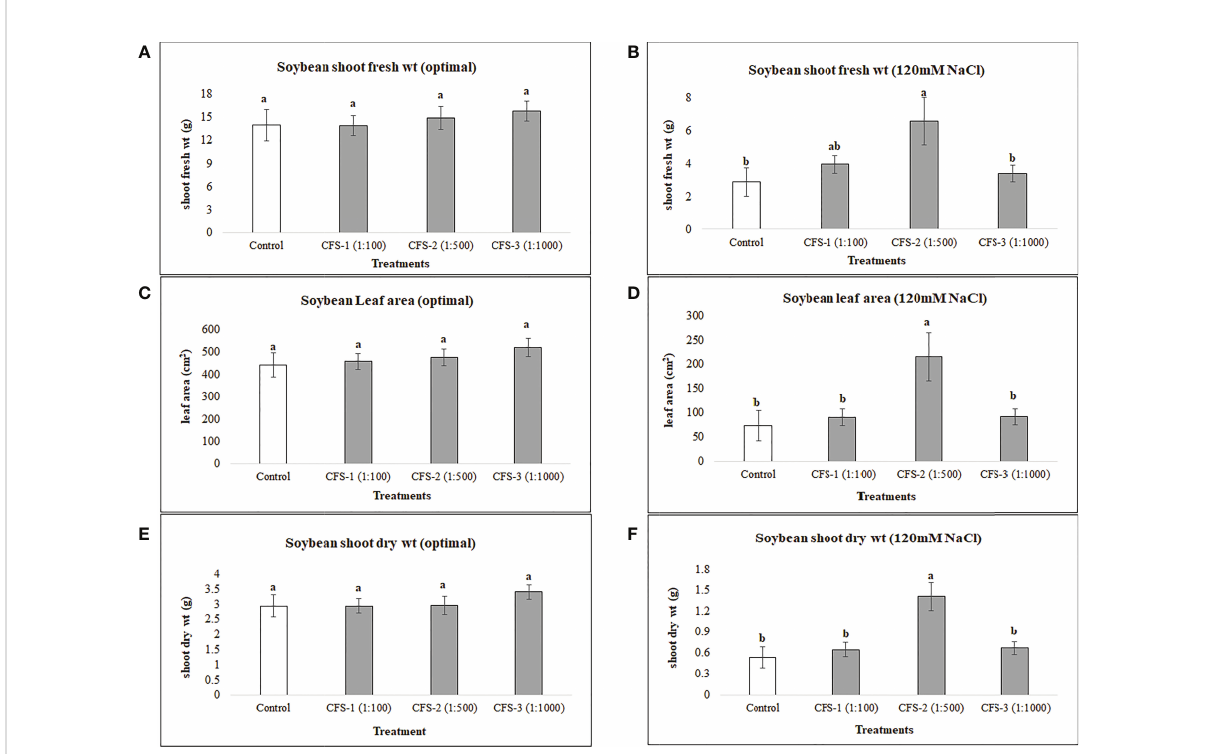
FIGURE 2 Soybean above ground biomass affected by CFS (A) shoot fresh wt - optimal (B) shoot fresh wt – 120 mM NaCl (C) shoot dry wt - optimal (D) shoot dry wt – 120 mM NaCl (E) leaf area - optimal (F) leaf area – 120 mM NaCl. The data represents the mean values of 8 replications (n=8) ± standard error. Different letters indicate values determined by Tukey ’ s multiple mean comparison to be signi fi cantly different (p< 0.05) from each